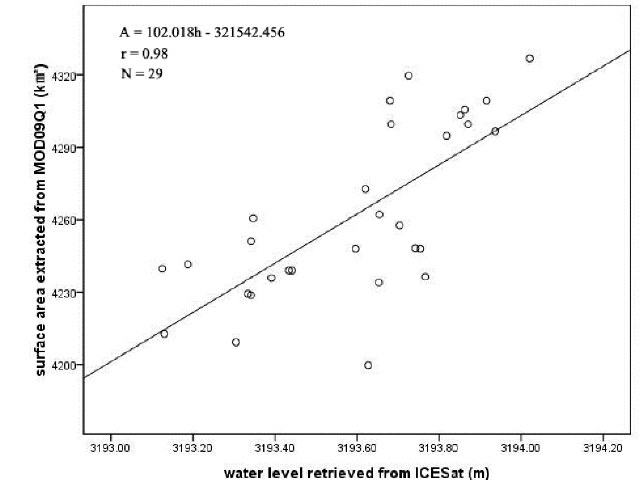
Figure 6. The empirical relationship between water levels and surface areas of Lake Qinghai, which was established by using the surface areas retrieved from MOD09Q1 and water levels retrieved from ICEsat as